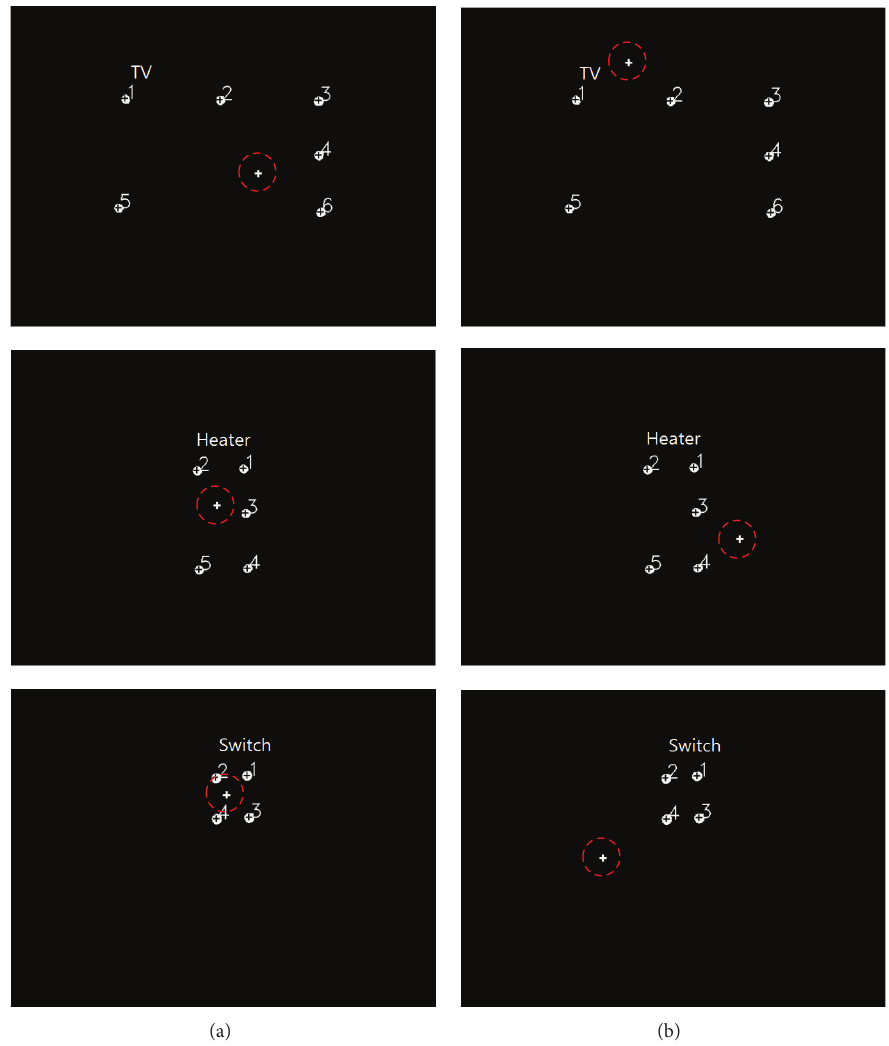
Figure 13: Examples of (a) selection and (b) nonselection of a home appliance by gaze estimation. Note that the red dotted circles indicate the calculated gaze position.